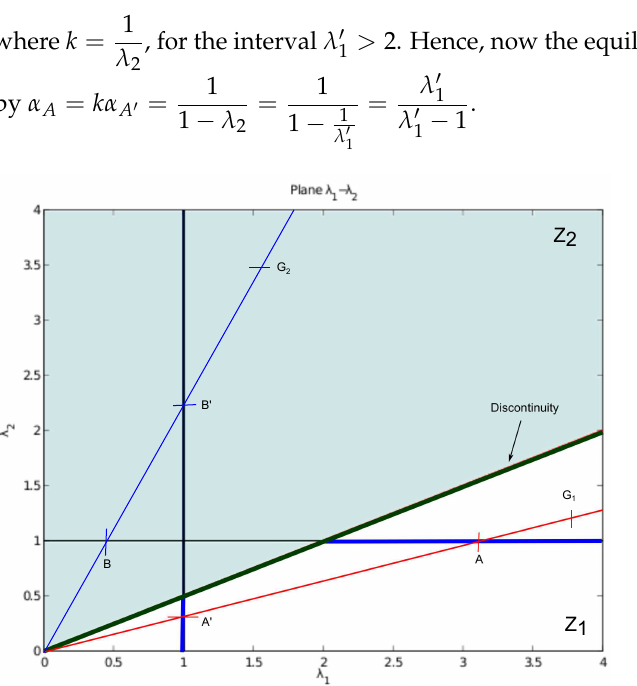
Figure 9. Plane λ 1 − λ 2 . The firing rate vector when λ 2 is varied (i.e., λ = [ 1 λ 2 ] T ) is composed of the points in line A’B’; its corresponding equilibrium throughput is shown in Figure 8b. Multiplying such a vector by k = 1 results in λ (cid:48) = [ 1 1 ] T , a vector described by the points in line BA; its equilibrium λ 2 λ 2 throughput is depicted in Figure 8c.